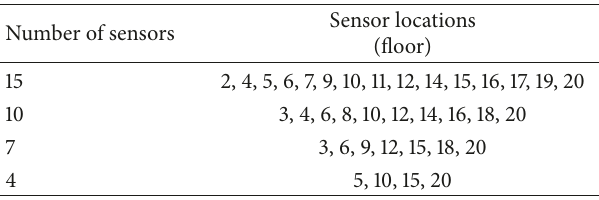
Table 6: The mean value and standard deviation of errors for the estimated wind load with +5% error in natural frequencies.